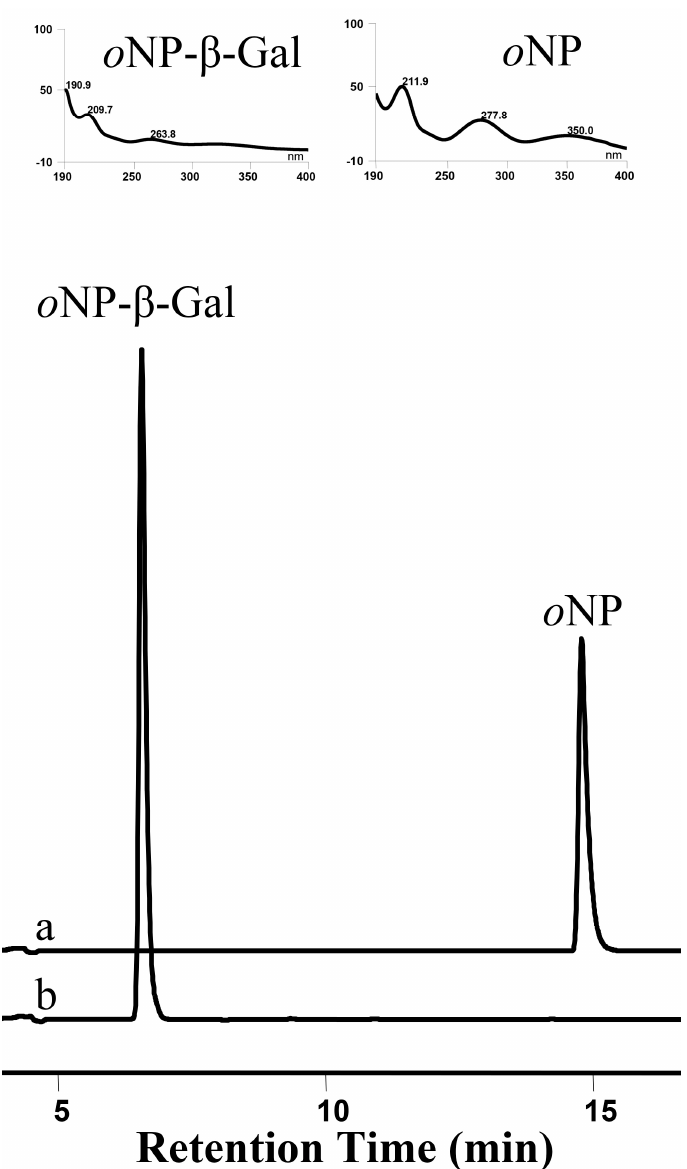
Figure 7. HPLC chromatogram of hydrolysis reaction of o NP- β -Gal in the presence (a) or absence (b) OsUGT1. UV spectra of o NP- β -Gal and o NP are shown in upper panels. o NP- β -Gal: o -nitrophenyl- β - D